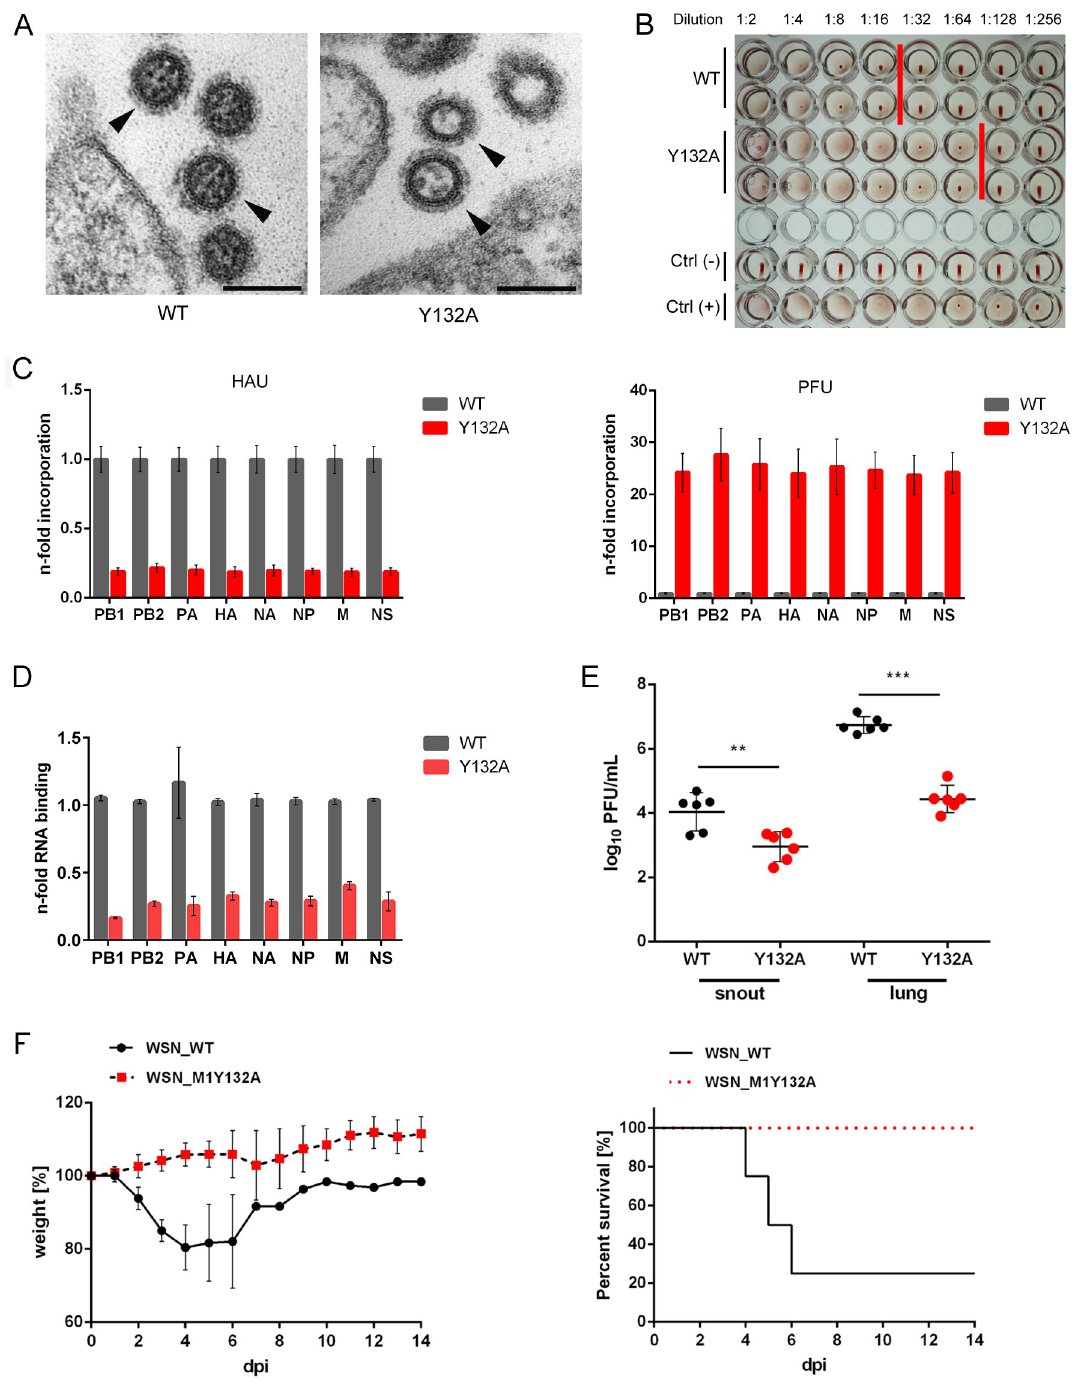
Fig 6. Phosphorylation of M1 Y132 is required for efficient vRNP packaging into budding virions and conveys virus pathogenicity in mice. A) A549 cells were infected with WSN WT or M1 Y132A (MOI 5) for 9 h. Cells were fixed with 2.5% glutaraldehyde and processed for EM as described for Fig 3. Scale bar: 100 nm. B) Analysis of the relative amount of viral particles in supernatants from WSN WT or M1 Y132A-infected MDCKII cells by HA assays with a defined number of 7x10 5 infectious particles. One representative of two independent experiments is shown. C) Virus-containing supernatants of WSN WT- or M1 Y132A-infected MDCKII cells (0.1 MOI; 48 hpi) were harvested, infectious titers were determined by standard plaque assays and HAU were analyzed by HA assays. Incorporation of vRNAs into viral particles was analyzed by qRT-PCR and normalized to the total amount of particles (HAU/pfu; left) or the amount of infectious particles (right). vRNA levels of WSN WT particles were arbitrarily set to 1. Depicted are mean vRNA